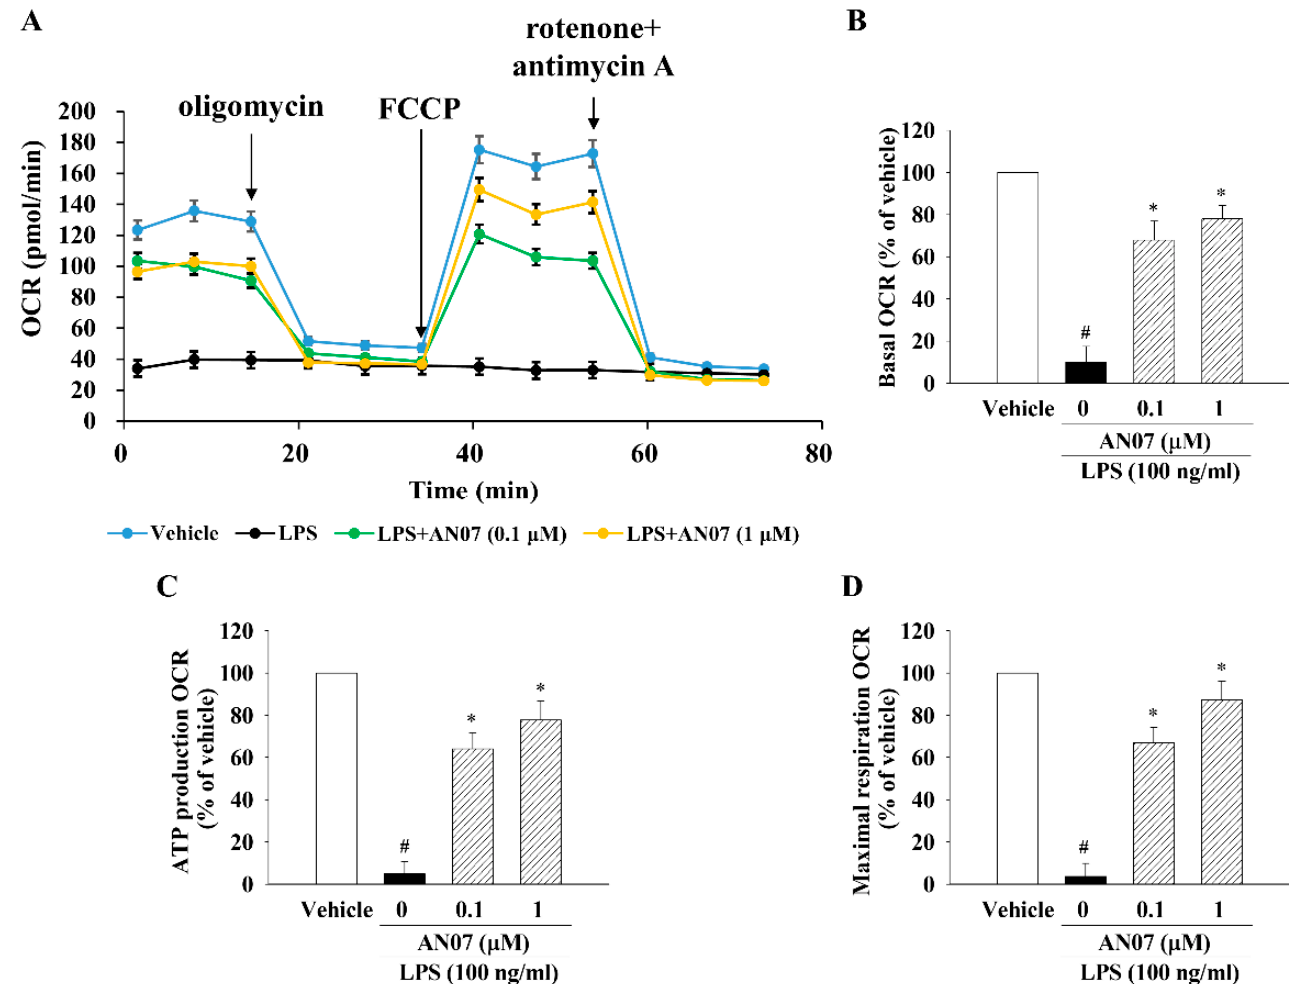
Figure 4 . AN07 improved LPS-induced reduction of mitochondrial oxygen consumption rate (OCR) in C2C12 myotubes. Myotubes were pretreated with AN07 (0.1 and 1 μ M) for 1 h followed by LPS (100 ng/mL) treatment for 24 h. OCR was measured by Seahorse XFp analyzer. Oligomycin (1 μ M), FCCP (1 μ M), and a rotenone/antimycin-A mix (1 μ M) were added at times indicated by arrows. ( A ) Representative readouts of OCR. Quantification of ( B ) basal OCR, ( C ) ATP production OCR, and ( D ) maximal respiration OCR. Data represent the mean ± SEM from six independent experiments (n = 6). # p < 0.05 vs. control group (vehicle only); * p < 0.05 vs. LPS-treated group according to Kruskal–Wallis test followed by Dunn’s